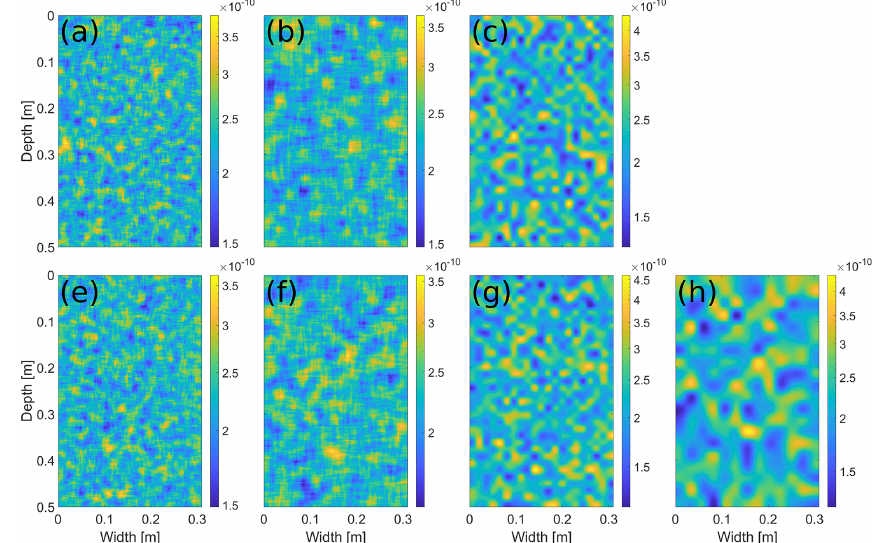
Figure A2. The distribution of the intrinsic permeability κ (m 2 ). The distributions satisfy the following: (a) κ max /κ min ≈ 2 . 60, (b) κ max /κ min ≈ 2 . 50, (c) κ max /κ min ≈ 3 . 40, (e) κ max /κ min ≈ 2 . 45, (f) κ max /κ min ≈ 2 . 35, (g) κ max /κ min ≈ 3 . 90, and (h) κ max /κ min ≈ 3 . 50. Intrinsic permeability values are color coded according to the color bar on the right.